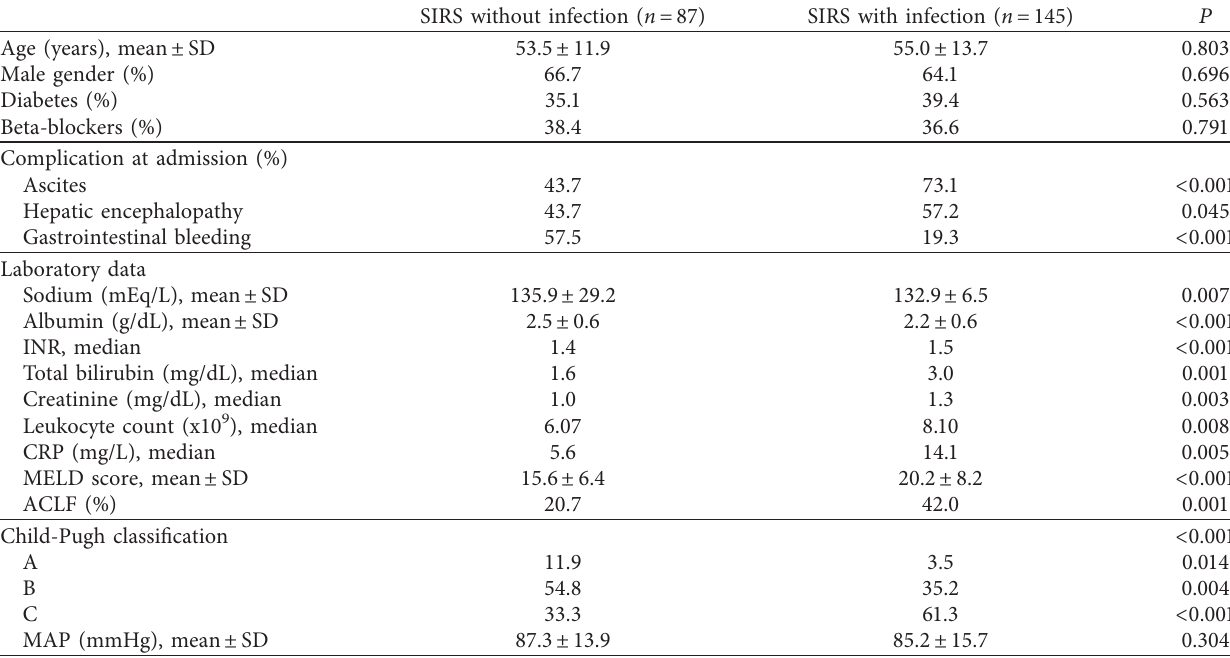
Table 3: Factors associated with the presence of infection among patients with SIRS.